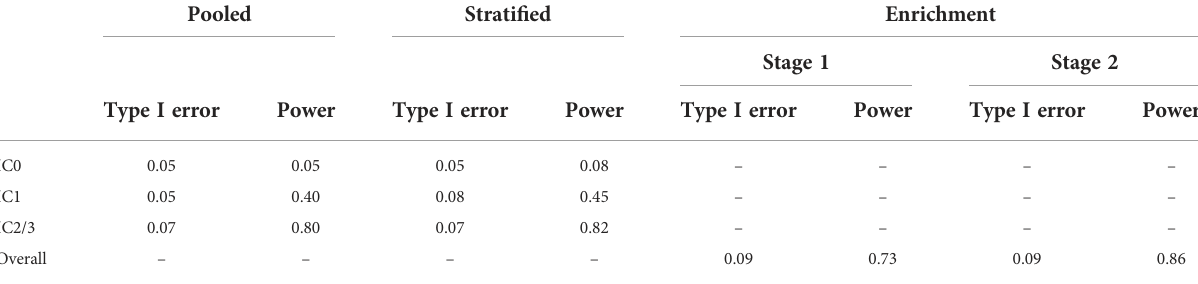
TABLE 1 Type I error and power for each biomarker-speci fi c subgroup under the pooled control arm and strati fi ed control arm designs, and the overall type I error and power for the enrichment design.